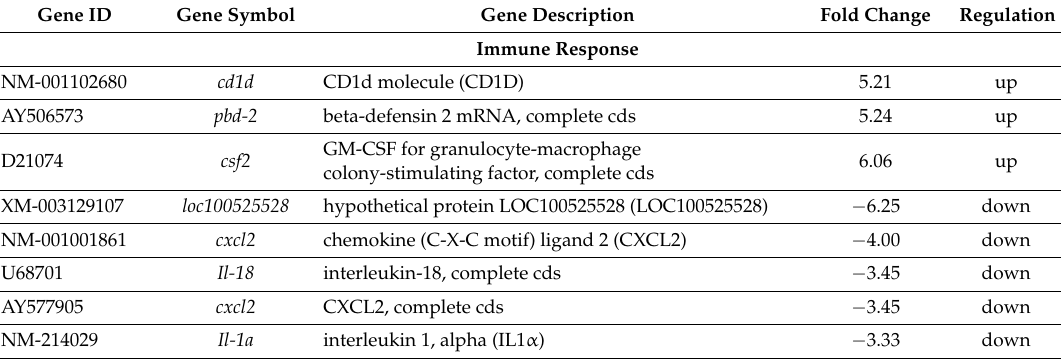
Table 5. List of the most strongly upregulated or downregulated genes involved in immune response in